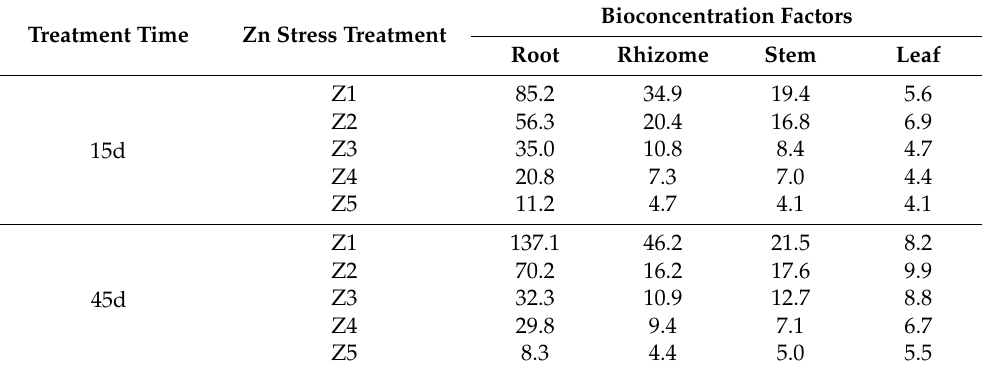
Table 1. Impacts of different treatment times and Zn treatments on the bioaccumulation factor in four organs. Z1, Z2, Z3, Z4 and Z5 indicate that the Zn concentrations are 75, 150, 300, 600 and 1000 mg/L, respectively.